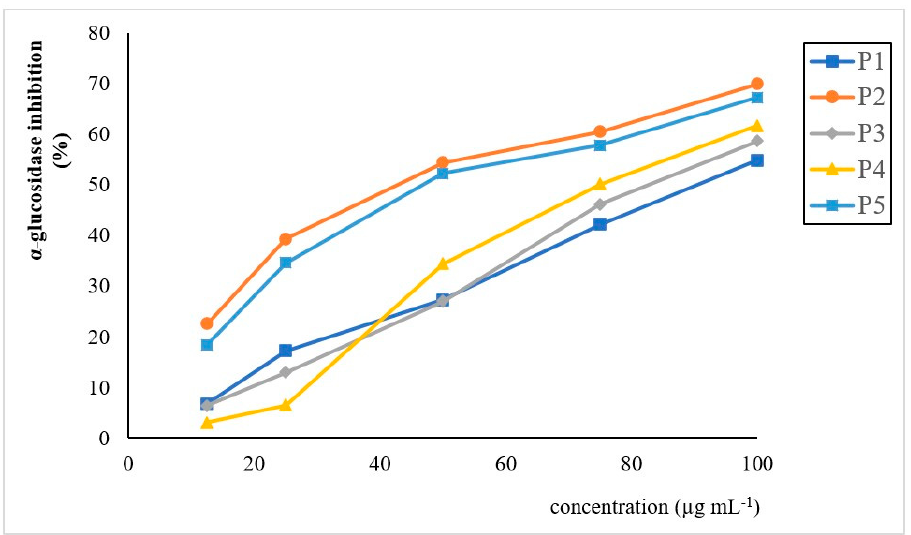
Figure 7. Percentage of inhibition of the a-glucosidase enzyme by extracts of A. unedo wild berries.